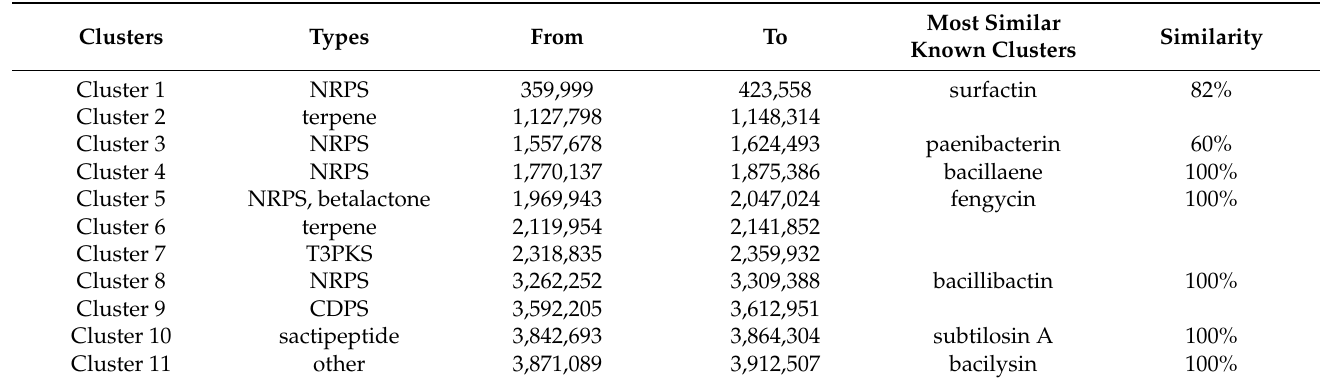
Table 4. The putative gene clusters for synthesis of secondary metabolites in B. subtilis YB-15 genome analyzed by